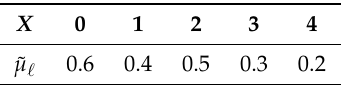
Table 2. The length of ( X , ˜ µ )